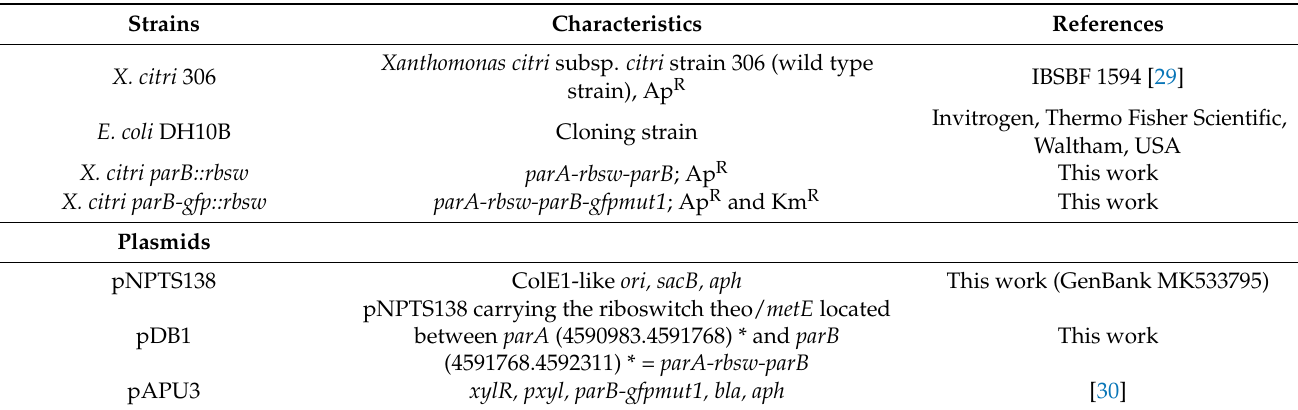
Table 1. List of strains and plasmids used in this